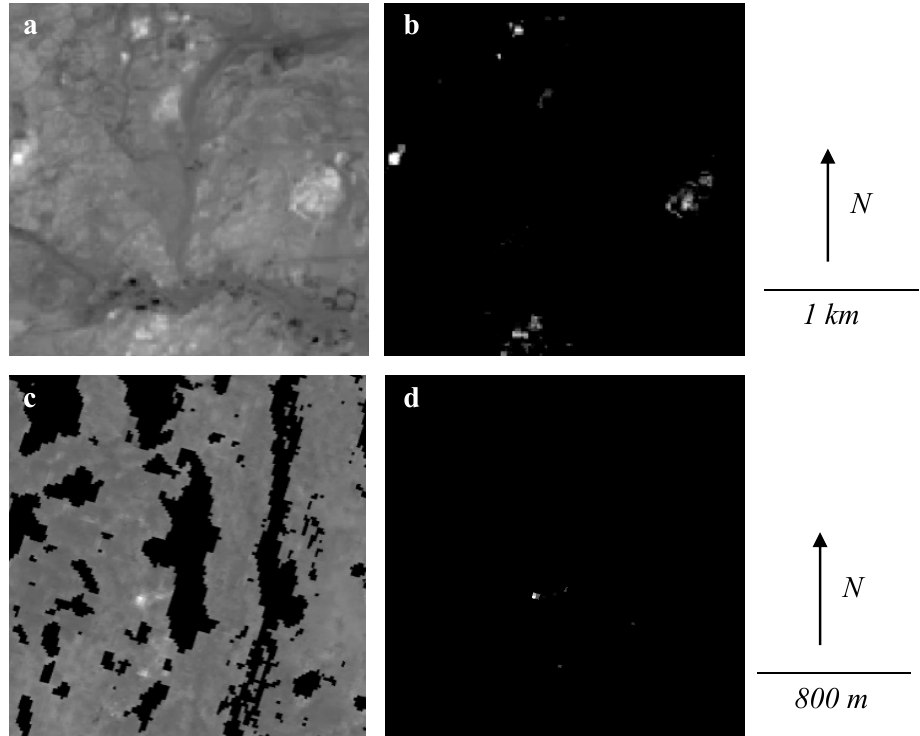
Figure 9. B4/B2 band ratio ( a ) and IFD ( b ) applied on the Khunayqiyah gossans in Saudi Arabia (long: 45.0794653; lat: 24.2805029). B4/B2 band ratio ( c ) and IFD ( d ) applied on the High Lake gossan in Canada (bottom; long: − 110.8473047; lat: 67.3826313). The gossans are highlighted by the brightest pixels in both band ratio and IFD.